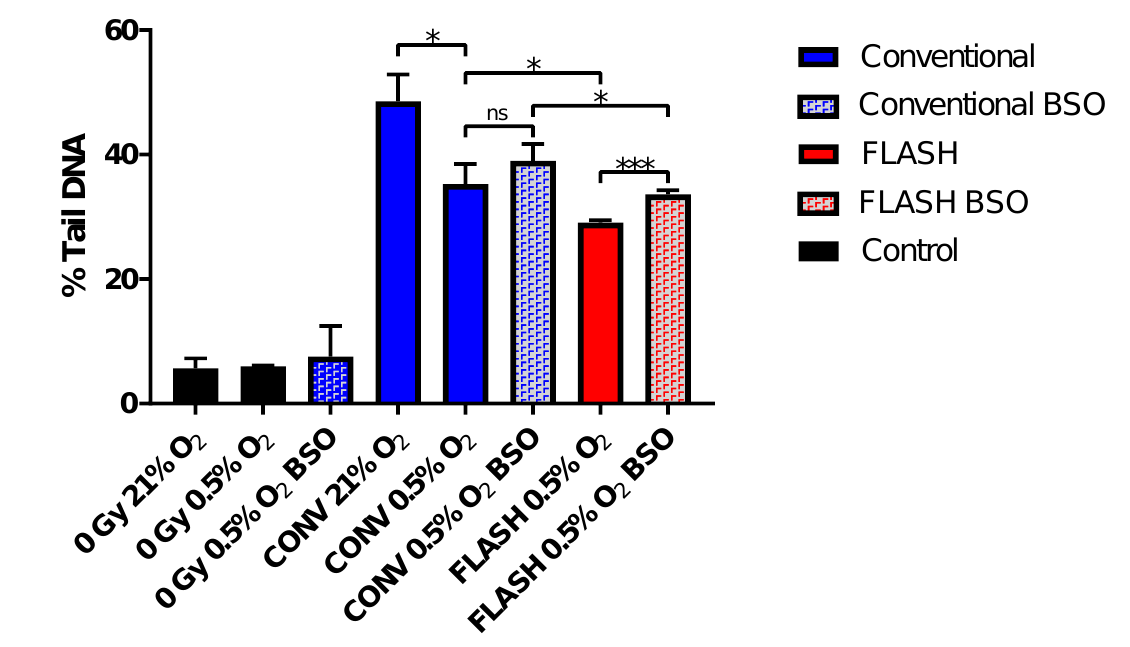
Figure 4. Alkaline Comet assay measures of DNA damage formation (% Tail DNA) in whole-blood peripheral blood lymphocytes (WB-PBL) following 20 Gy CONV or FLASH irradiation at 21 or 0.5% O 2 , after treatment of WB-PBL with buthionine sulfoximine (BSO). Data are expressed as the mean % Tail DNA of three slides ( n = 3). Error bars indicate standard deviation of the means for each experimental condition. Statistical significance (two-tailed unpaired t -test) is indicated with *, where * is p < 0.05 and *** is p < 0.001, non-significant (ns) is p > 0.05.